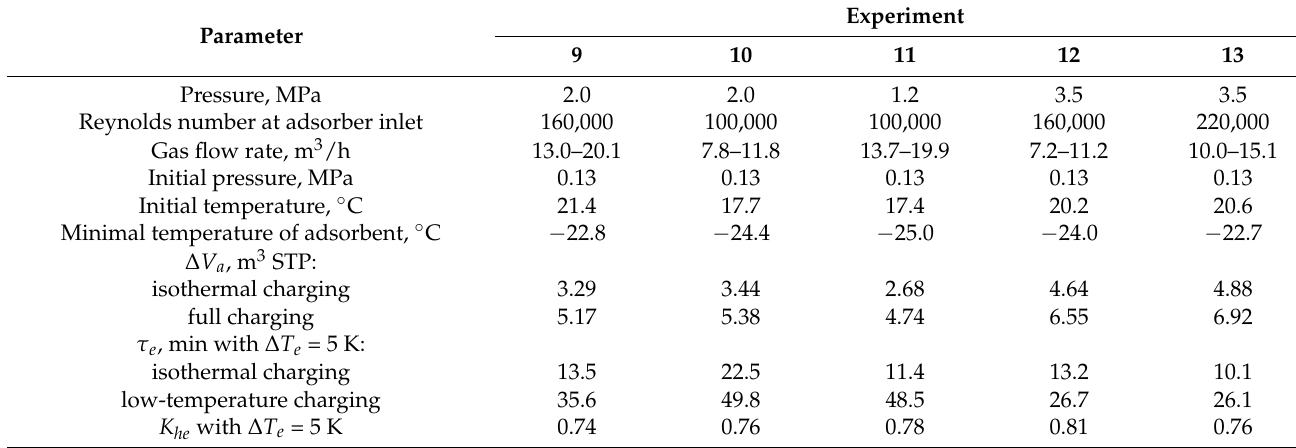
Table 2. Modes and results of the experiments with constant pressure and gas flow mode (Reynolds number).